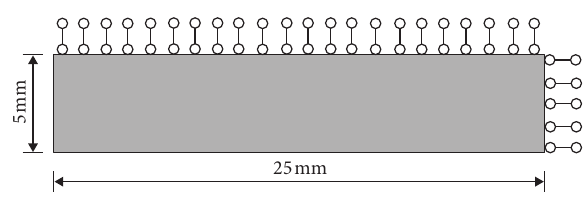
Figure 4: Al 2 O 3 ceramic slab in